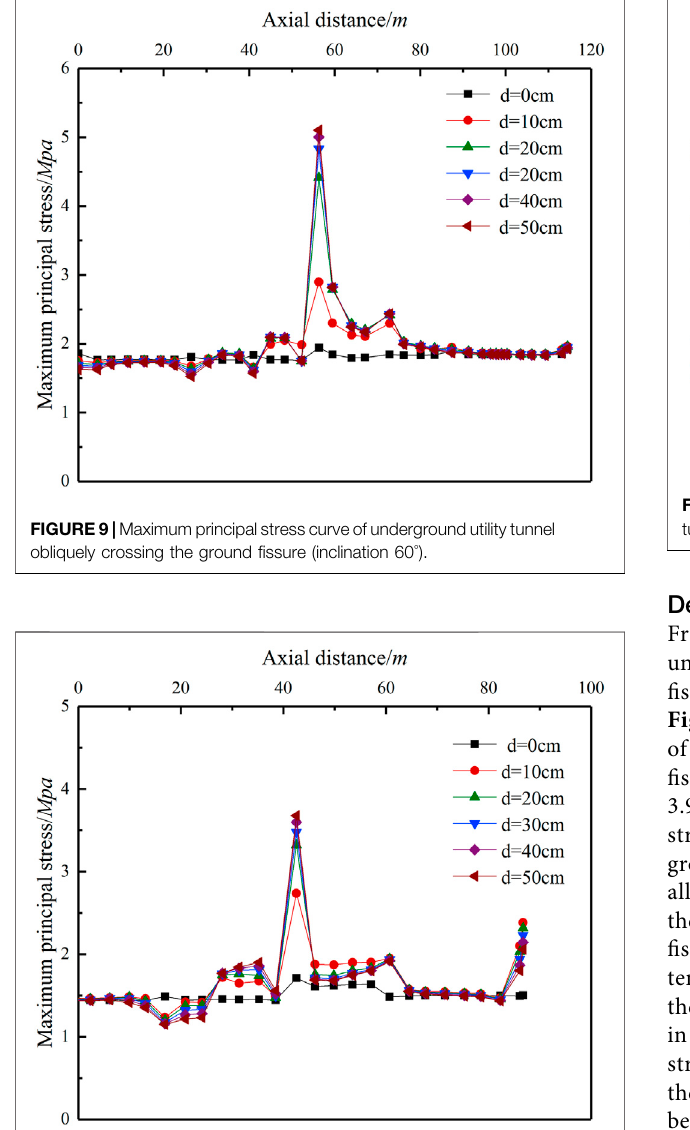
Frontiers in Earth Science |